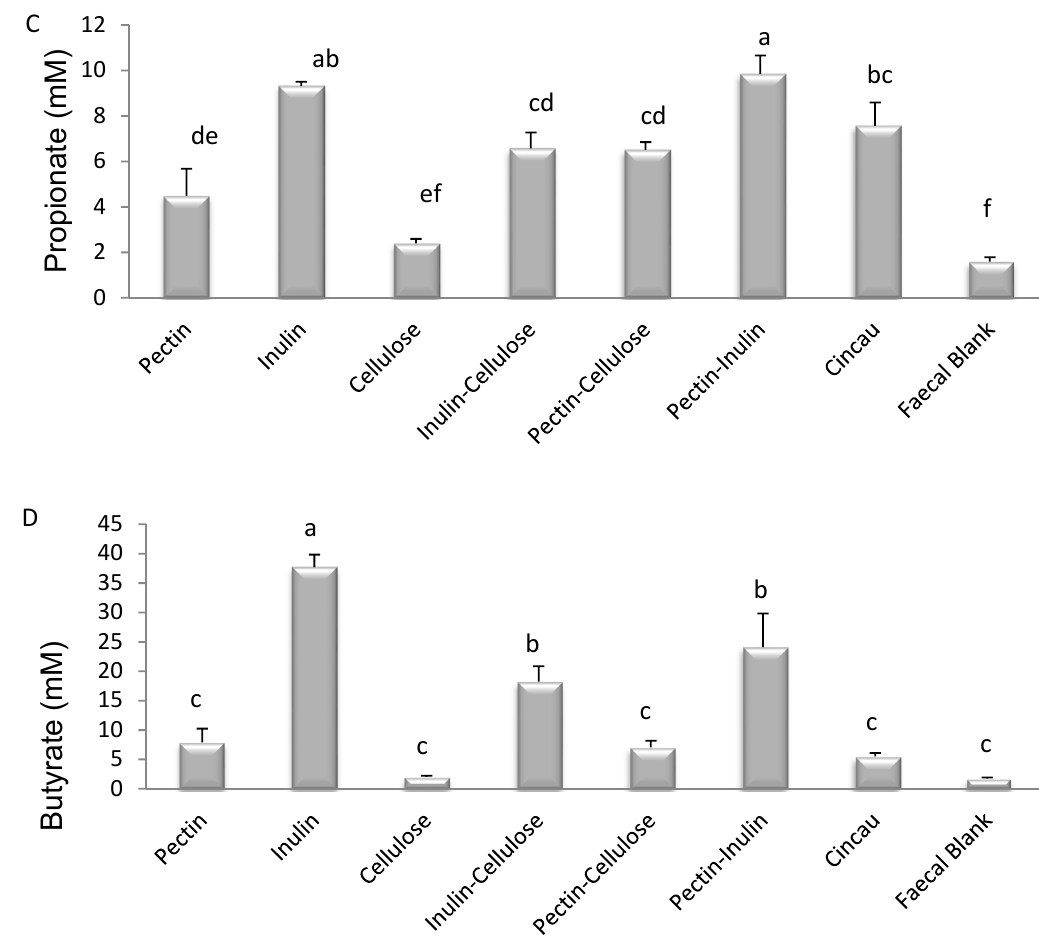
Figure 1. Effect of dietary fibre on the concentration of short chain fatty acid (SCFA) total ( A ), acetate ( B ), propionate ( C ), and butyrate ( D ) in fermentation supernatants. Dietary fibre/s were fermented with human faecal bacteria at 37 ◦ C for 24 h in anaerobic conditions. The bars represent the mean, and the lines are SEM of four replicates. Data points denoted by different superscripts (letters above the bar) differ significantly when p < 0.05.